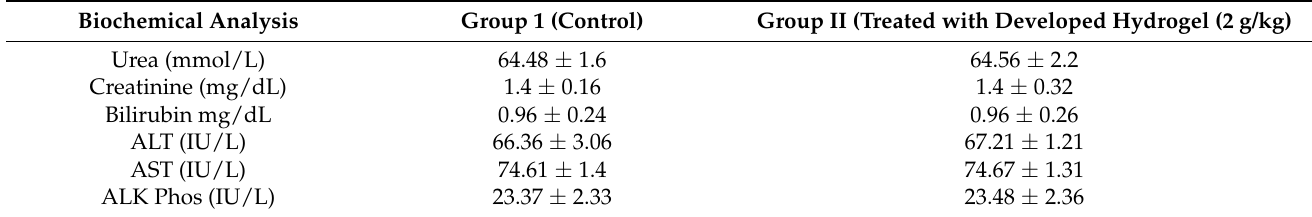
Table 4. Biochemical analysis of HP β CD polymeric hydrogel treated